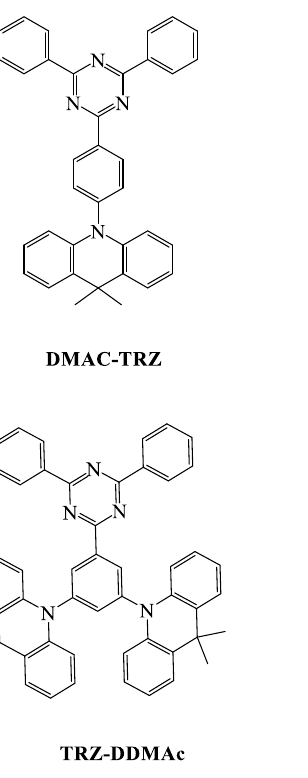
Figure 6. Molecular structures of triazine acceptors with acridine donor moieties.